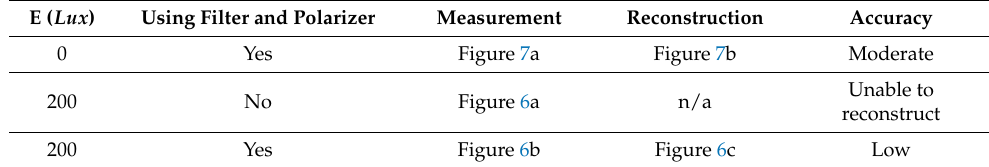
Table 1. Summary of measurement and reconstruction at spatial frequency being 0.3 lp /mm.